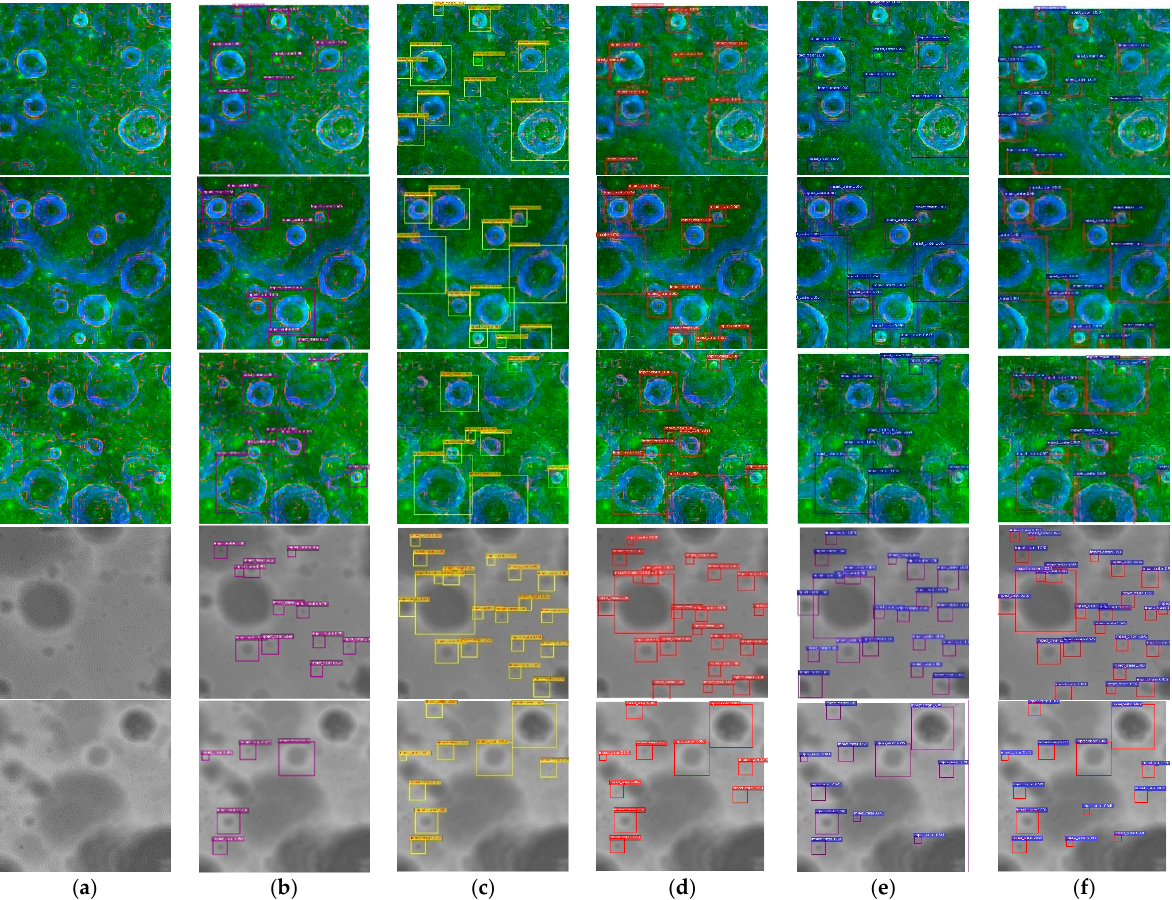
Figure 12. Comparison of the impact crater detection for different models: ( a ) Origin DEM, ( b ) ResNet, ( c ) ResNeXt, ( d ) ScNet, ( e ) ResNeSt, and ( f ) Our model. Table 3. Added ROI network parameter comparison.